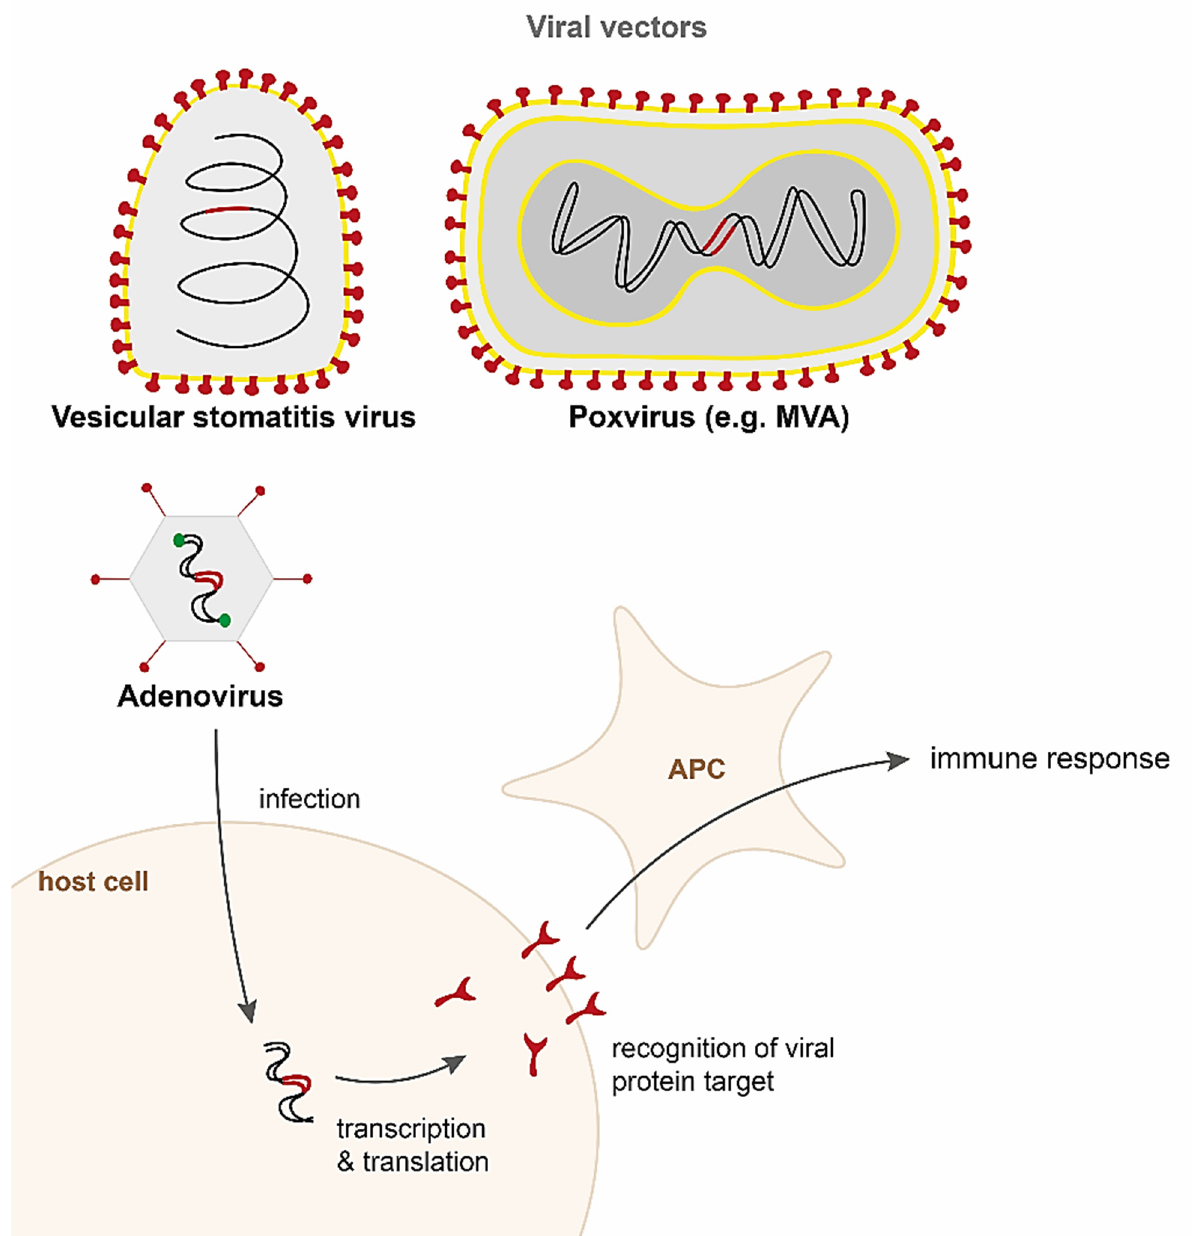
Figure 2. Delivery of vaccines by viral vectors. Schematic diagrams representing the viral vectors vesicular stomatitis virus (VSV), poxviruses, and adenoviruses encode the target viral antigen (red). Entry into the host cell is driven by proteins expressed by the vector. The target viral antigen is expressed and recognised by the host immune system. Antigen processing cells (APC) engulf the antigens and activate the adaptive immune response to elicit antibody and T cell responses.